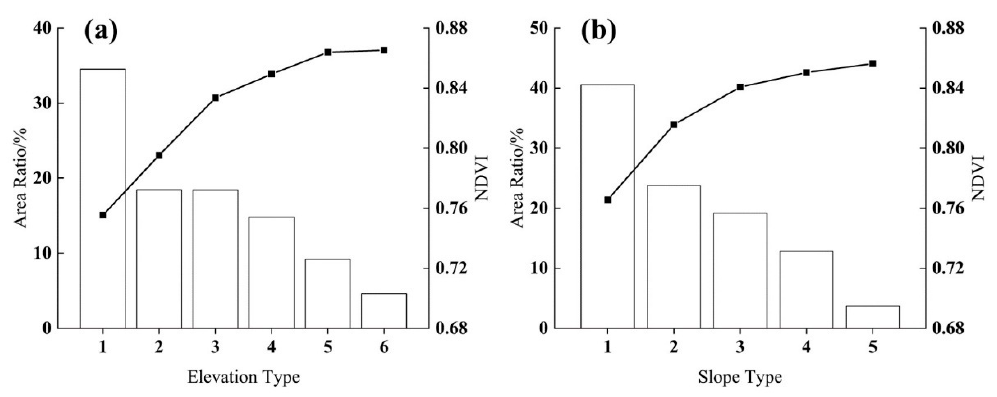
Figure 10. NDVI values of different elevation and slope ranges: ( a ) elevation; ( b ) slope.